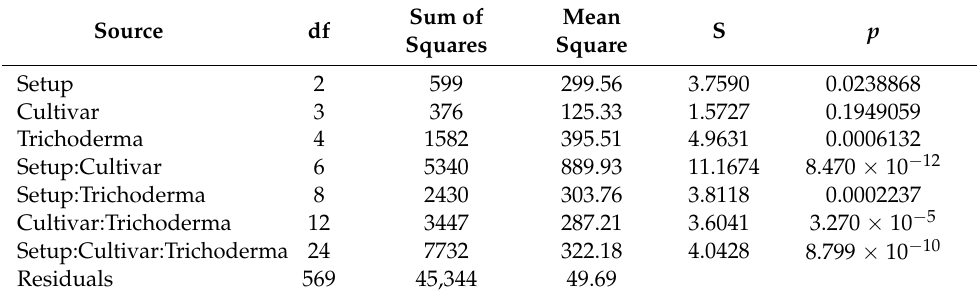
Table 1. Results of a Multifactorial Analysis of Variance (MANOVA) for the effects of Setup, Cultivar and Trichoderma spp. on anthracnose severity (% diseased leaf